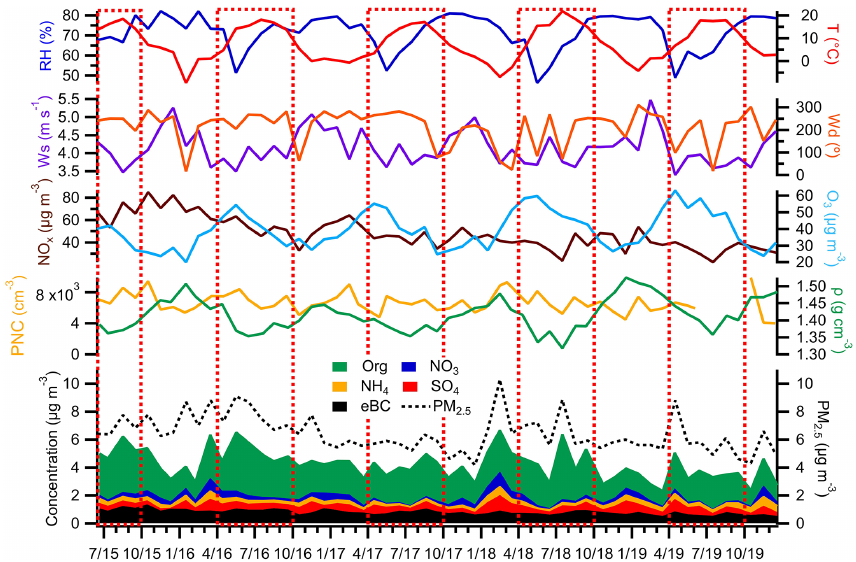
Figure 1. Temporal variation (monthly median) of PM 1 chemical species (organics, NO 3 , NH 4 , SO 4 , and eBC), PM 2 . 5 (determined by TEOM), PNC (measured by DMPS), particle density, atmospheric oxidants (NO x and O 3 ), and the most relevant meteorological parameters (Wd (monthly mean), Ws (monthly mean), T , RH). Red dotted rectangles represent the warmest period of the year